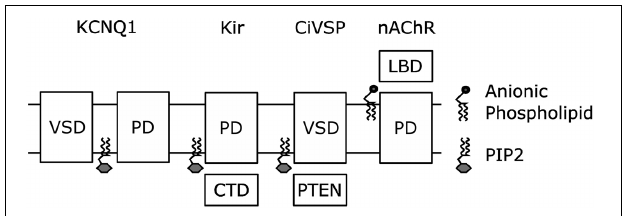
FIGURE 5 | Coupling of modular sensor and effector domains as a general mechanism for the regulation of transmembrane proteins by PIP 2 or other anionic